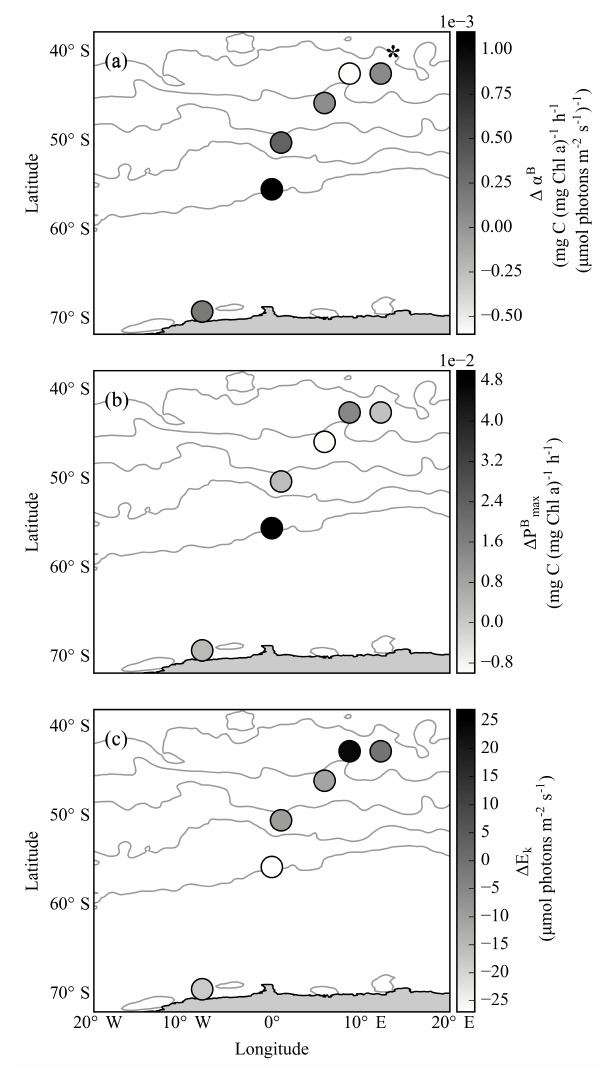
Figure 3. Experimental values of (a) (cid:49)α B (mgC(mgChl a ) − 1 h − 1 (µmolphotonsm − 2 s − 1 ) − 1 ) , (b) (cid:49)P B max (mgC(mgChl a ) − 1 h − 1 ) and (c) (cid:49)E k (µmolphotonsm − 2 s − 1 ) for experiments set up in the Atlantic sector of the Southern Ocean. Ocean fronts, indicated by grey lines, were determined from MADT from the CLS/AVISO product (Rio et al., 2011) and their position averaged over 5 months (November 2015 to March 2016). * Position of experiment 3 moved 2.5 ◦ eastwards for presentation